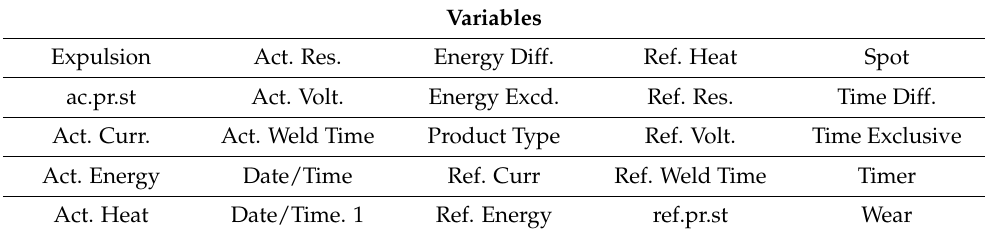
Table 2. Raw variables as candidate features for spot welding parameter